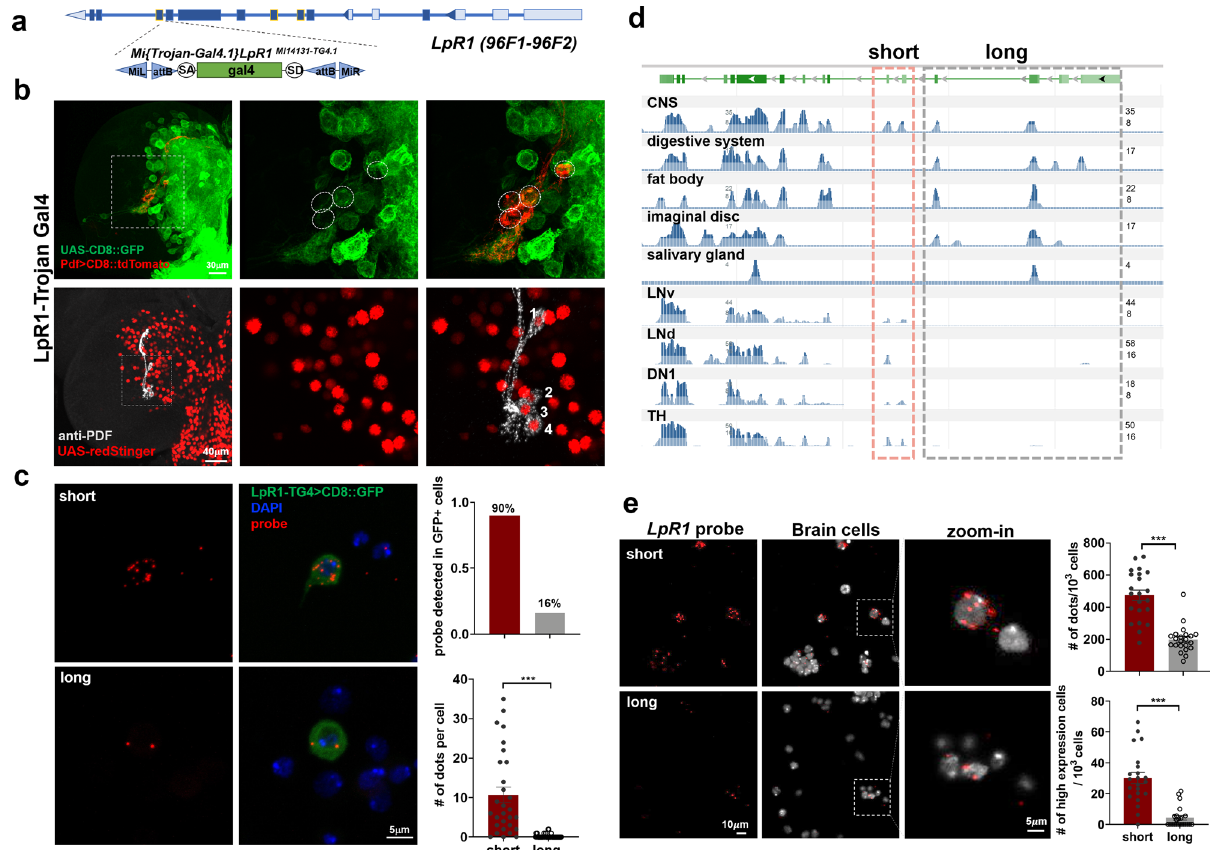
Fig. 2 LpR1-short exhibits brain-speci fi c expression and is the dominant isoform in the larval brain. a , b LpR1 is widely distributed in the larval brain. a Schematic diagram of a Trojan-Gal4 insertion at the 3 ’ end of the LpR1 gene (LpR1-TG4), which represents the expression of all LpR1 isoforms. b The broad distribution of LpR1 in the larval brain is detected by the LpR1-TG4 driving CD8::GFP (top) or redStinger (bottom) (observed in at least 10 brains). The expression of LpR1 in LNvs is con fi rmed by co-labeling using either Pdf-LexA driving tdTomato (red, circles in top panels) or anti-PDF antibody (gray, numbers in bottom panels). c LpR1-short is the dominant isoform expressed in the larval brain. Representative confocal images (left, probe in red and GFP in green) and quanti fi cations (Right) from qFISH analyses on LpR1 -expressing brain cells are shown. In the bottom graph, data are presented as mean values + / − SEM. p < 0.0001, t = 6.143, df = 78, by two-tailed Student ’ s t -test. n = 30 and 50 for short and long. n represents individual GFP positive cells. *** p < 0.001. d LpR1-short expression is detected in CNS and four types of adult neurons, but not in the peripheral tissues, where only LpR1-long- expression is detected. Tissue-speci fi c and neuron-speci fi c RNA-seq displays reads from isoform-speci fi c exons (short-red frame, long-gray frame, reads number log base 2 scaled). e LpR1-short is more abundant than LpR1-long in the larval brain. Representative confocal images (Left, probe: red; DAPI: gray) and quanti fi cations (Right) from qFISH analyses on dissociated brain cells are shown. Compared to LpR1-long , LpR1-short shows higher total transcript levels in brain cells (# of dots/1000 cells) and the total number of cells with high expression (# of high expression cells/1000 cells). ≥ 4 dots/cell were counted as high expression. Data are presented as mean values + / − SEM. Statistical signi fi cance was assessed by a two-tailed Student ’ s t -test. Top: p < 0.0001, t = 7.368, df = 42. Bottom: p < 0.0001, t = 6.593, df = 42. n = 22 for both groups. n represents the individual quanti fi ed image. *** p <